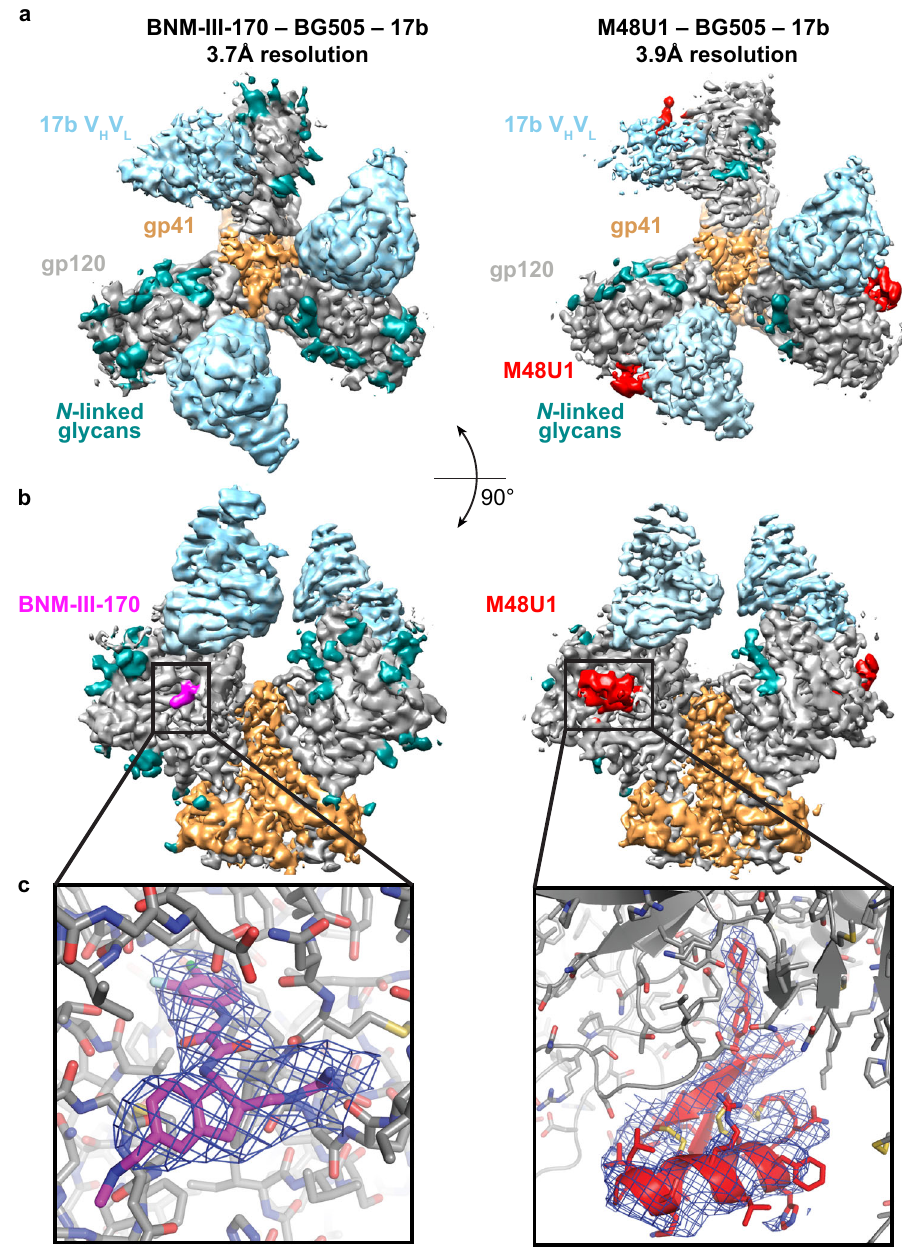
Fig. 1 Cryo-EM structures of BNM-III-170-BG505-17b and M48U1-BG505-17b. a Top-down view of density maps for BNM-III-170-BG505-17b and M48U1-BG505-17b complexes. b Side view of density maps for BNM-III-170-BG505-17b and M48U1-BG505-17b complexes. Boxed region indicates binding site for one CD4m molecule on each structure. c Close-up views of densities (blue) in CD4m binding sites. Densities are shown at 7 σ . Structure colors: 17b variable domain = light blue, gp120 = gray, gp41 = light orange, N-linked glycans = teal, BNM-III-170 = magenta, M48U1 = red, carbon atoms = gray, magenta, or red, oxygen atoms = red, nitrogen atoms = blue, sulfur atoms = yellow, chlorine atoms = green, fl uorine atoms = pale